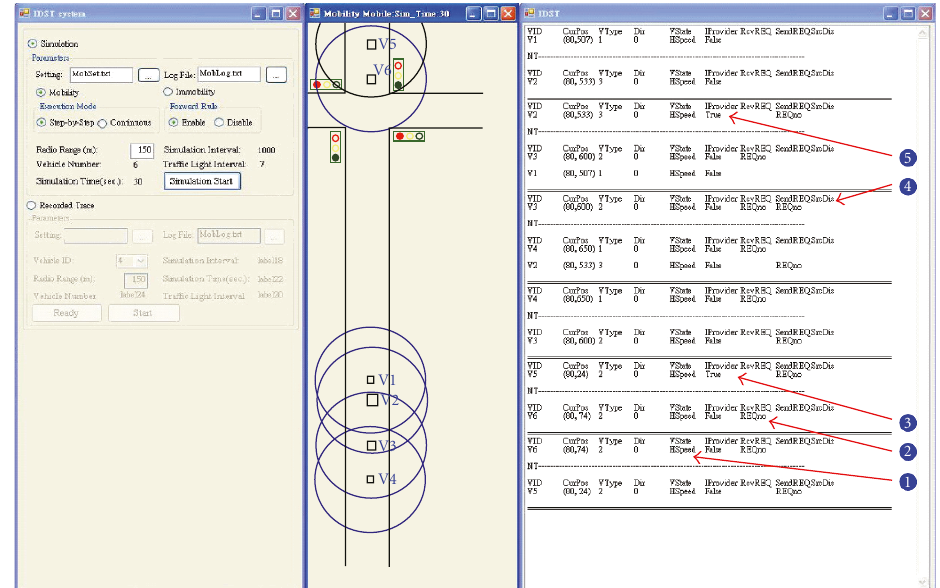
Figure 6: The screen shot of IDST tool under the local simulation